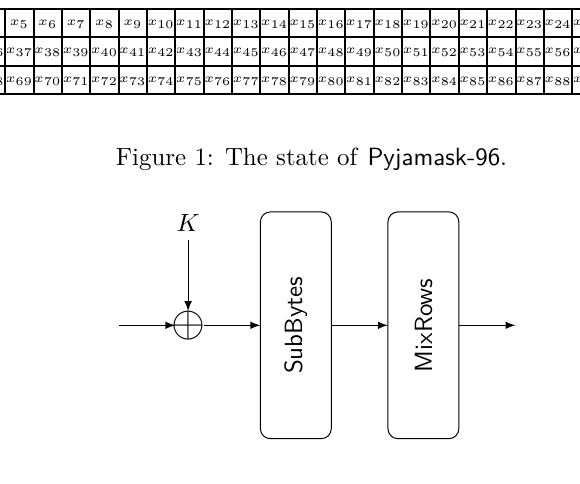
Figure 2: The round-function of Pyjamask-96